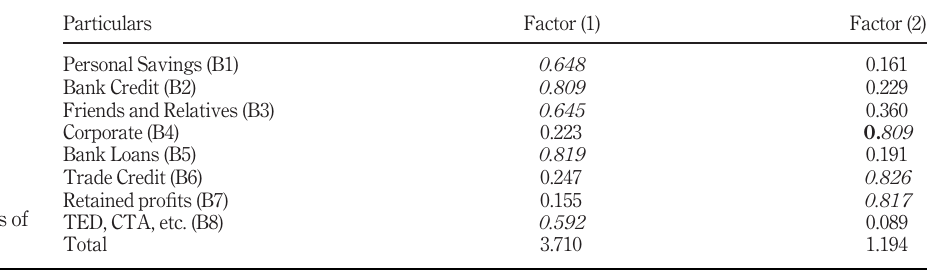
Table IV. Clustering of stimulating factors of Tibetan entrepreneurs based on the source of credit in order to run the